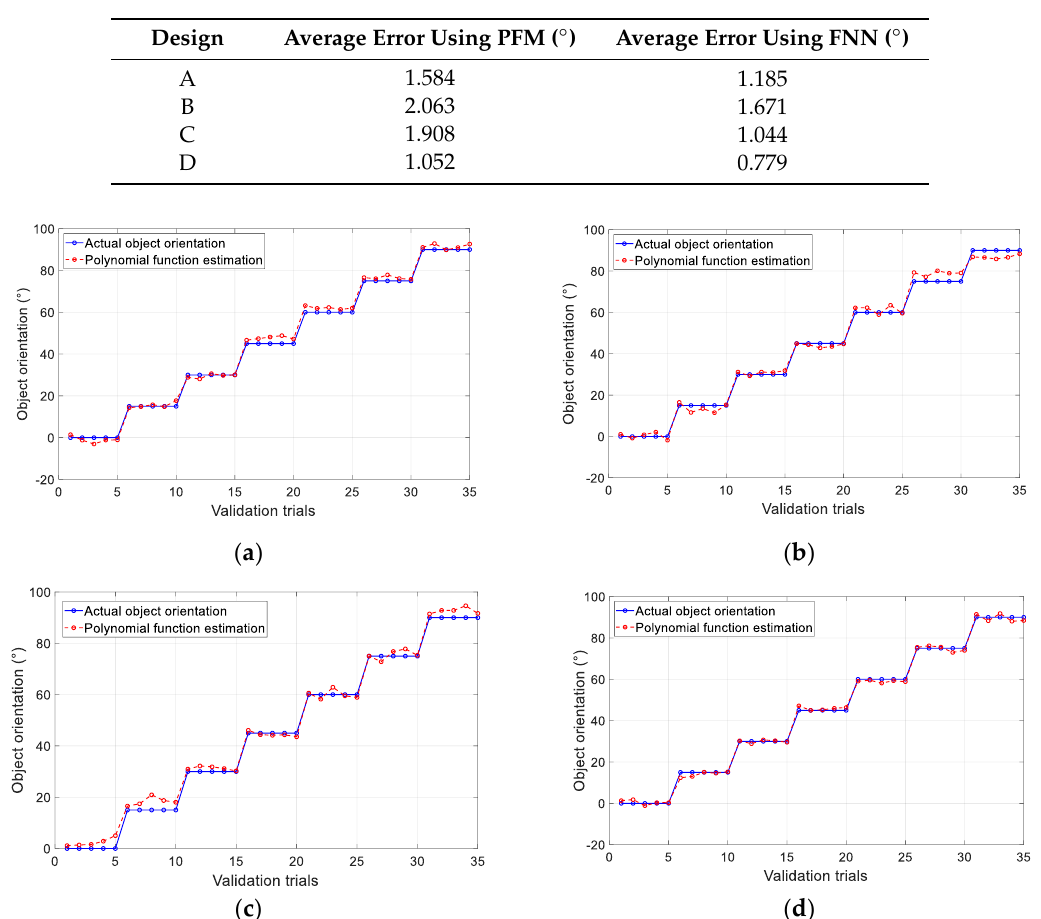
Table 2. Average estimated error in total validation trials for each design using polynomial fitting method (PFM) and feedforward neural network (FNN).